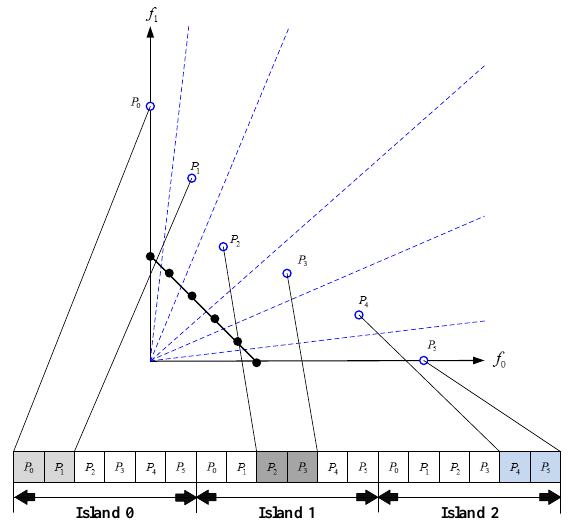
Figure 2. Illustration of a parallel global island